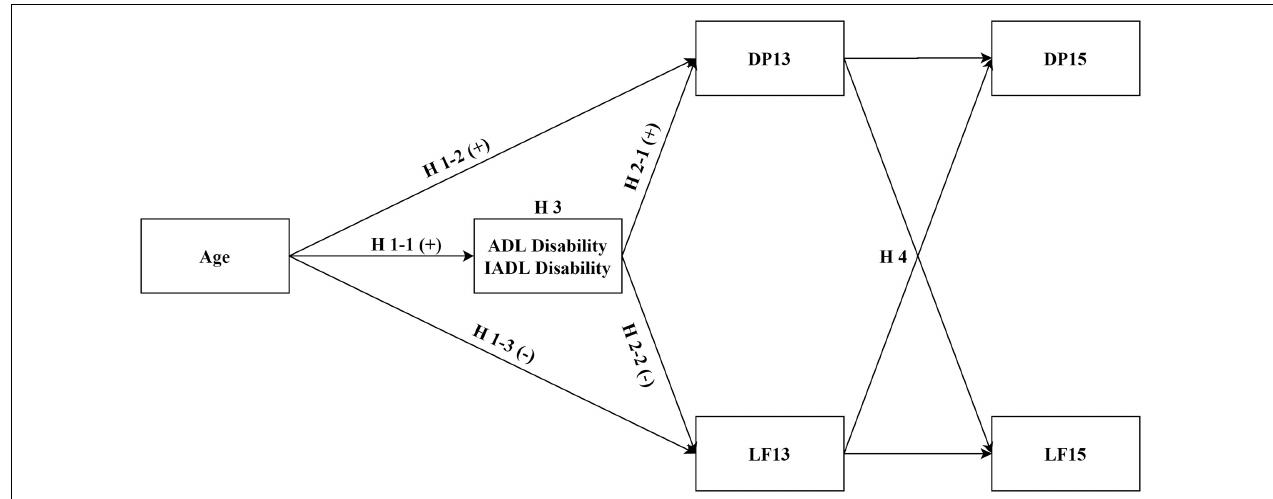
FIGURE 1 | Hypothesized model of the research framework. ADL, activities of daily living; IADL, instrumental activities of daily living; DP13, depression in 2013–2014; DP15, depression in 2015–2016; LF13, life satisfaction in 2013–2014; LF15, life satisfaction in 2015–2016. Hypotheses were that (H1-1) age would be positively correlated with functional disability; (H1-2) age would be positively correlated with depression; (H1-3) age would be negatively correlated with life satisfaction; (H2-1) functional disability would be positively correlated with depression; (H2-2) functional disability would be negatively correlated with life satisfaction; (H3) functional disability would mediate the relationships of age with depression and life satisfaction; and (H4) there would be a cross effect between depression and life satisfaction.